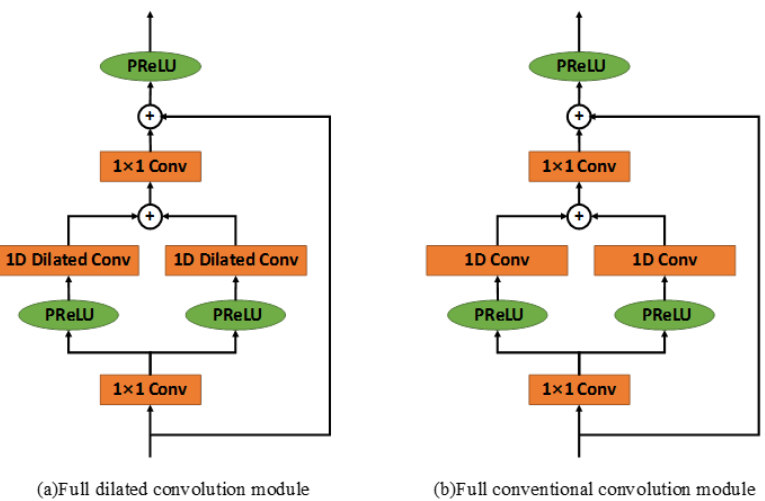
Figure 5. The full-dilated convolution module and full-conventional convolution module.